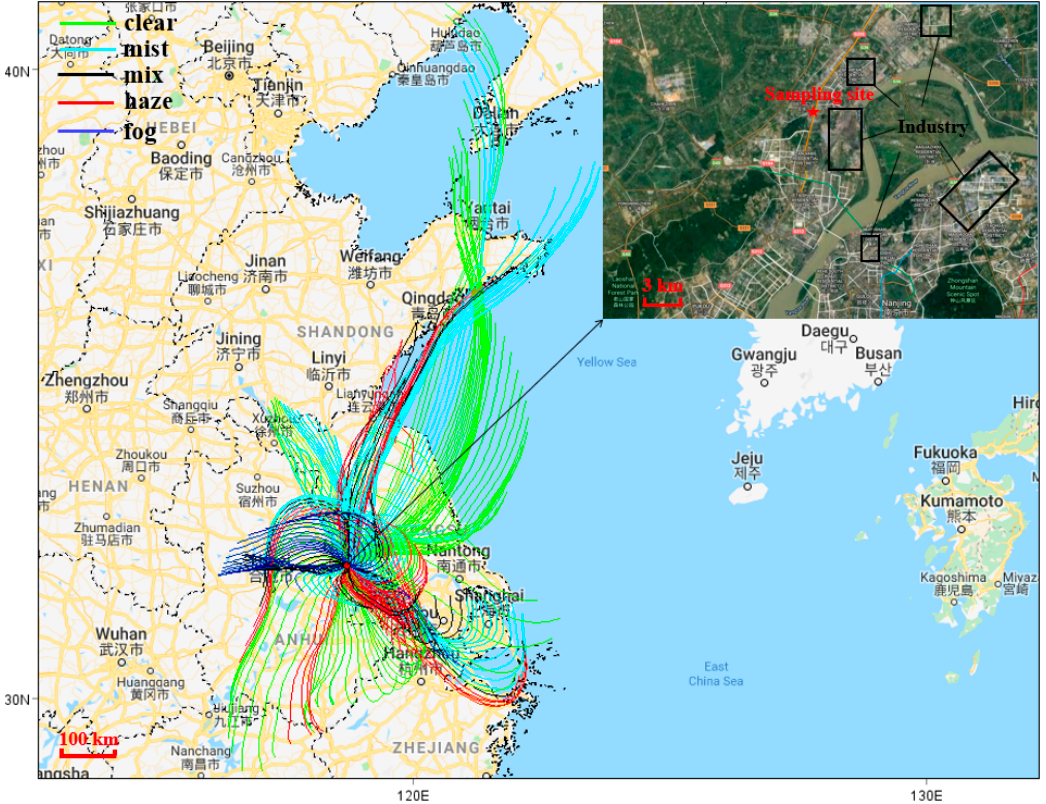
Figure 1. Observation site and 24 h backward trajectory at 500 m altitude.